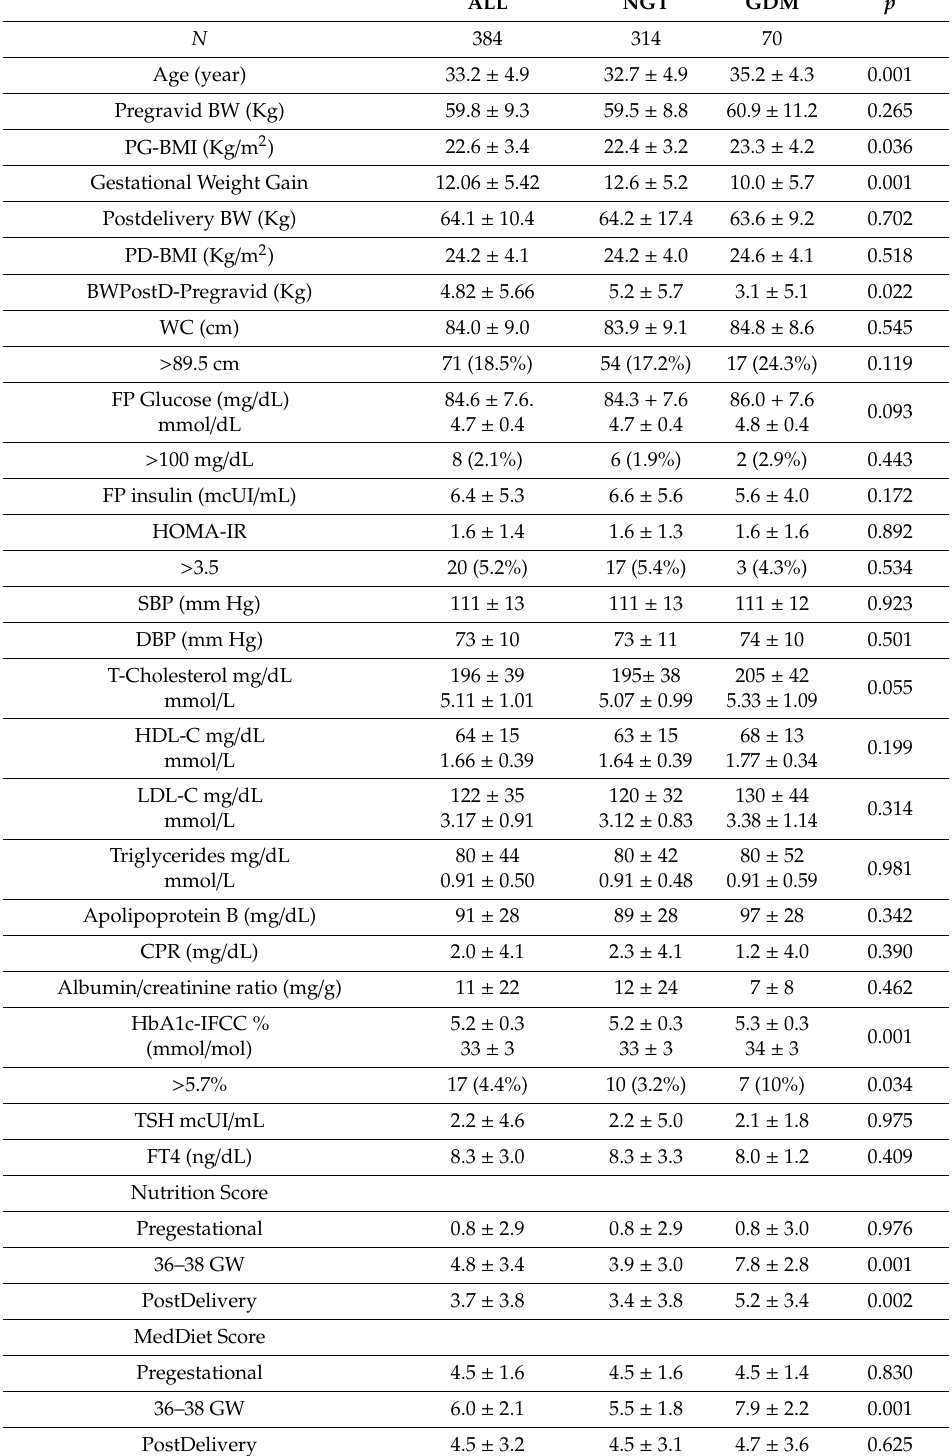
Data are Mean ± SDM or number (%). NGT, Normal glucose tolerance. GDM, Gestational Diabetes Mellitus. WC, waist circumference; BMI, Body mass index; BW, Body Weight; FP, fasting plasma; sBP, systolic blood pressure; dBP, diastolic blood pressure. PG, Pregravid; PostD,